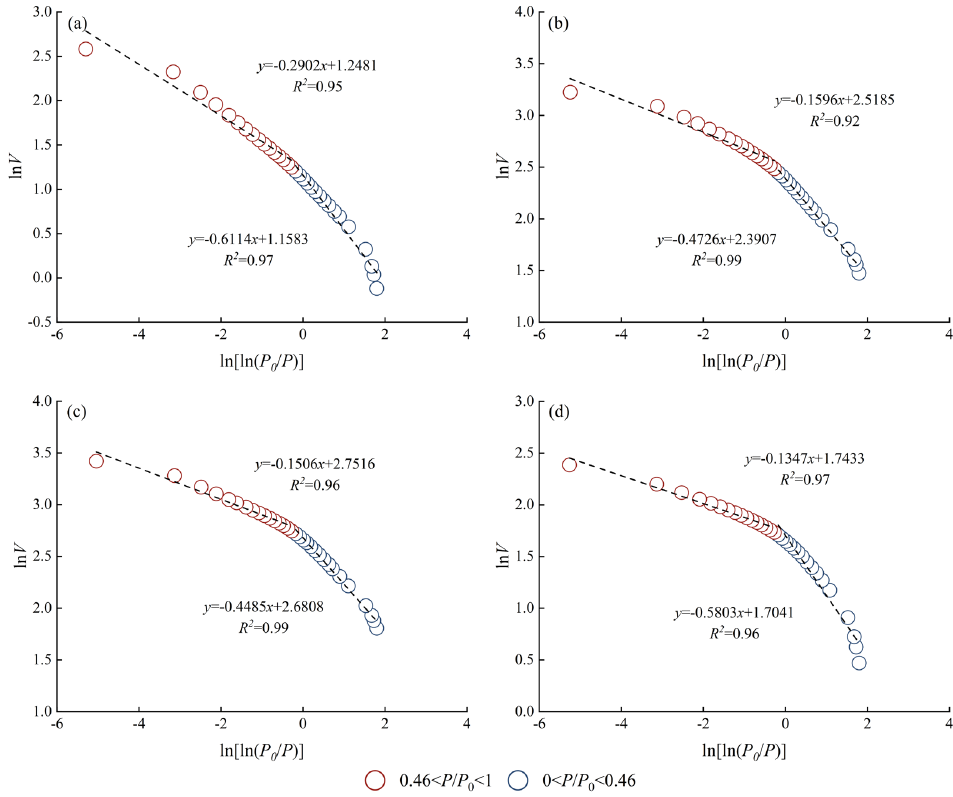
Figure 6. Sectional fitting diagram of ln V and ln [ln ( P 0 / P )] of typical samples. ( a ) Sample L1; ( b )